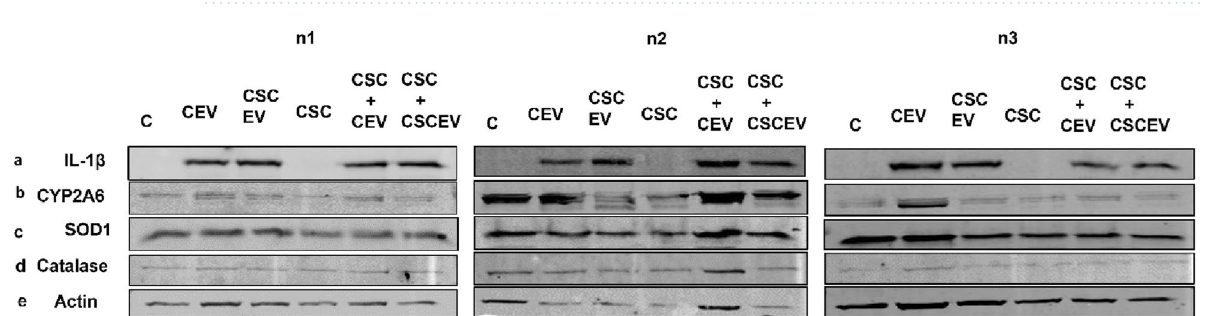
Figure 7. Effect of EVs derived from HIV-infected U1 macrophages on the levels of IL-1β, CYP2A6, and AOEs in SHSY-5Y cells. The neuronal cells (0.1 million cells/well/12well plate) were treated with EVs-derived from control (DMSO) and CSC-exposed (10 µg/ml/day for 7 days) U1-macrophages once daily for 2 days in the presence and absence of CSC (10 µg/ml/day). We observed more than 50% cell death after 2 days of treatment. Therefore, we harvested the cells after 2 days of treatment. We performed Western blot with an equal amount of protein loaded (5 µg of protein) to measure the protein expression of IL-1β ( a ), CYP2A6 ( b ), and antioxidant enzymes ( c & d). ‘ n ’ represents the number of replicates. CEV represents EVs isolated from the control group; CSCEV represents EVs isolated from the CSC-treatment